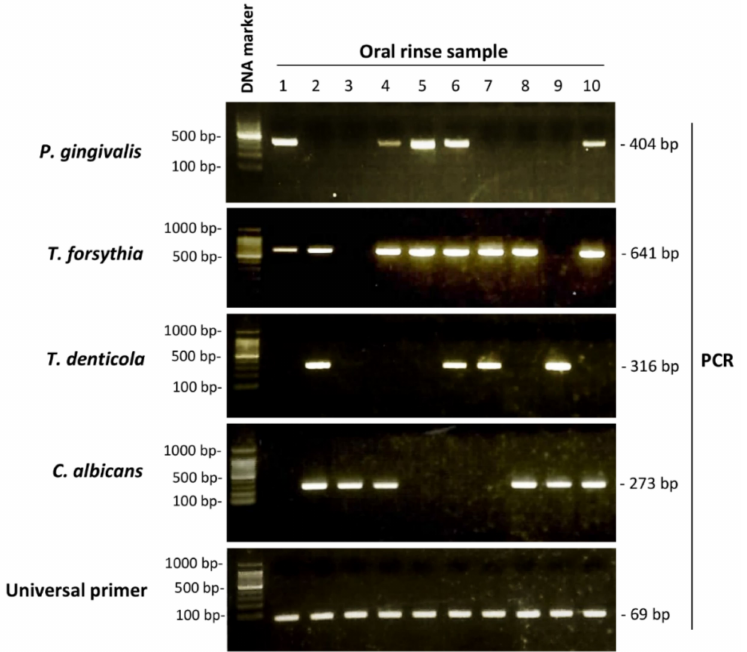
Figure 2. Polymerase chain reaction (PCR) detection of periodontopathic bacteria and candida. PCR was performed to detect DNA from P. gingivalis , T. forsythia , T. denticola , and C. albicans . PCR products were electrophoresed on 2% agarose gels, stained with ethidium bromide, and exposed to ultraviolet light using an ultraviolet